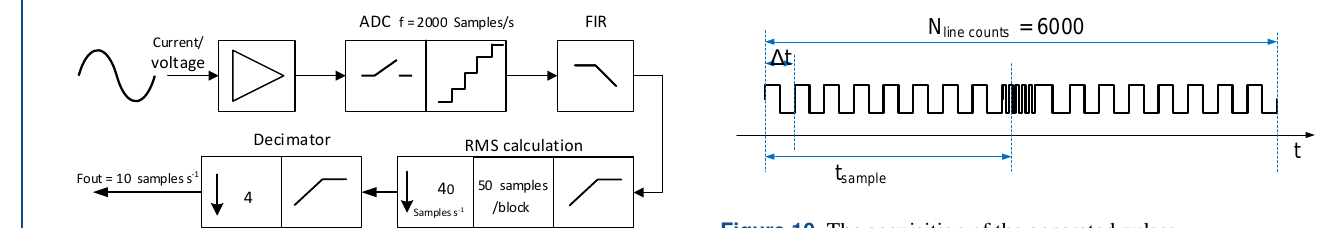
Figure 10. The acquisition of the generated pulses.